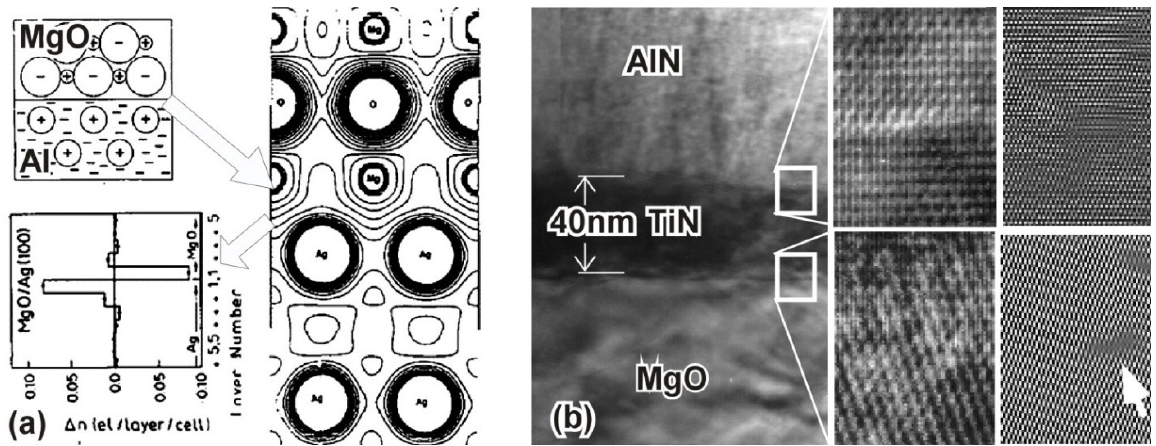
Figure 6. ( a ) First meaningful ab initio calculation of an metal-ceramic interface [8], model of the Ag/MgO interface, charge density at the interface, which differs significantly from each layer of the two bulk crystals; ( b ) TEM and HRTEM micrographs of the MgO/TiN/AlN interface including high-resolution images and filtered image showing only one misfit dislocation as marked by the arrow. (Figures reprinted with permission from publishers